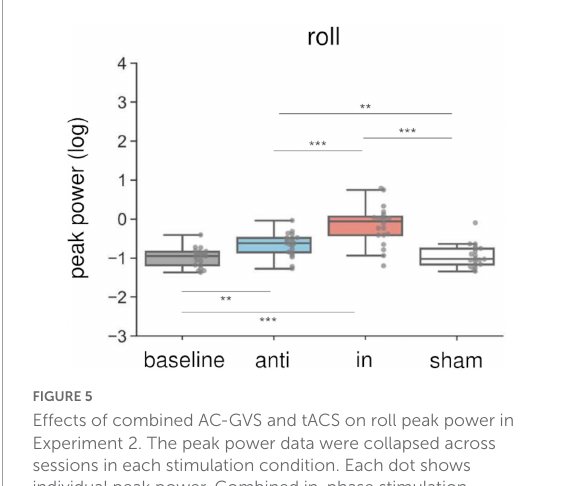
FIGURE5 Effects of combined AC-GVS and tACS on roll peak power in Experiment 2. The peak power data were collapsed across sessions in each stimulation condition. Each dot shows individual peak power. Combined in-phase stimulation facilitated the roll peak power compared with the baseline, sham, and anti-phase conditions. ** p < 0.01, *** p <